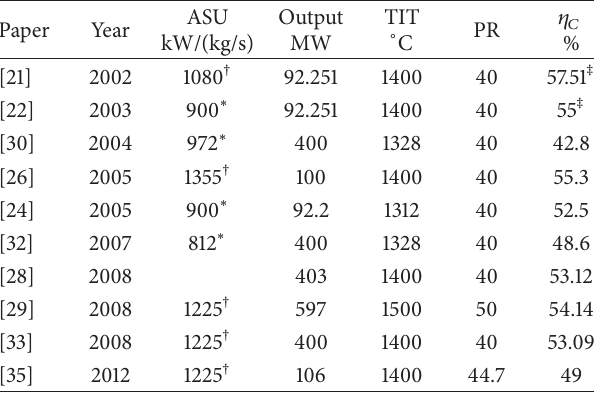
Table 2: Cycle performance for the Graz cycle from earlier papers.